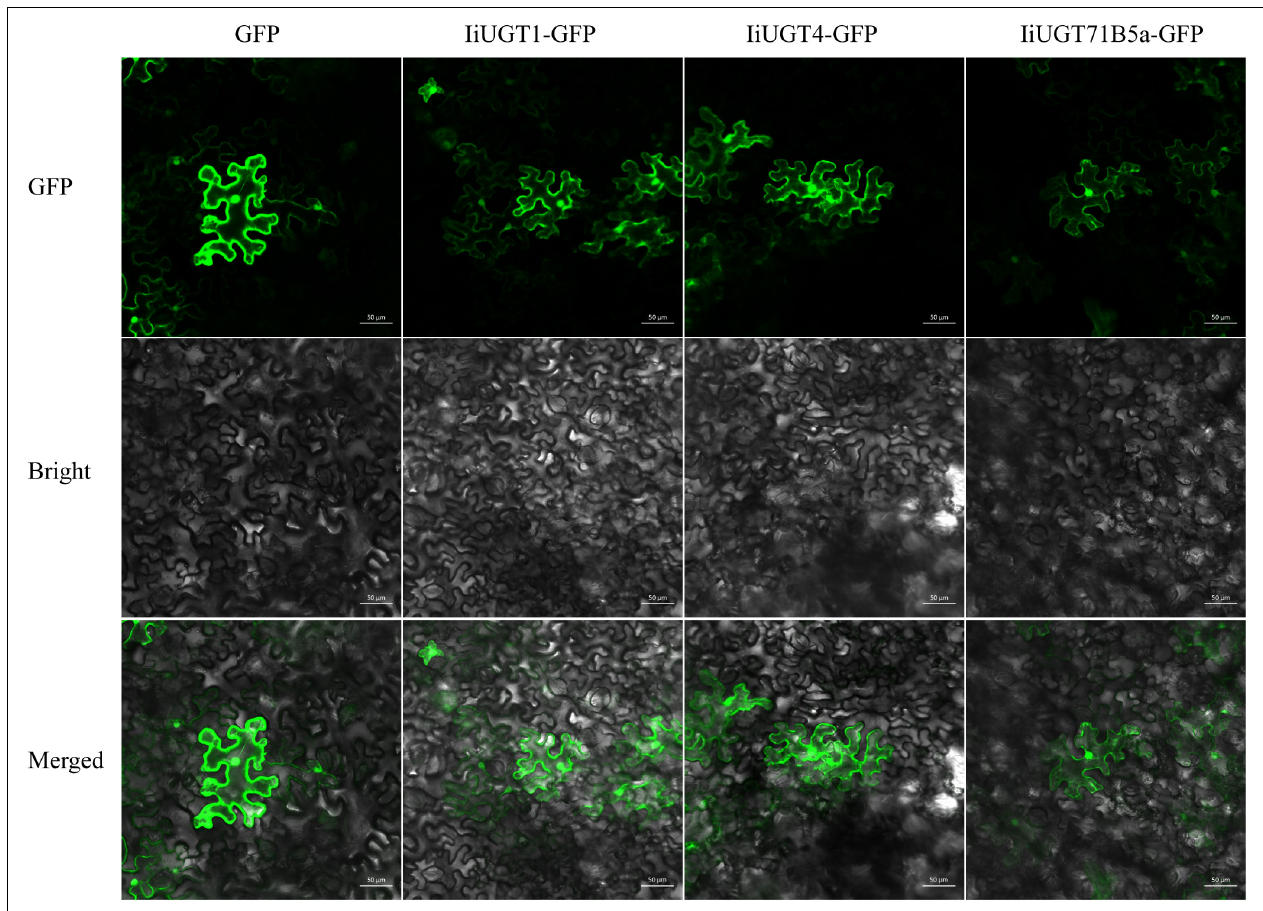
FIGURE 4 | Subcellular localization of IiUGTs fused with GFP at the C-terminus in N. benthamiana . GFP, GFP channel; Bright, light microscopy image; Merged, merged image of the GFP and Bright channels. Scale bars are 50 µ